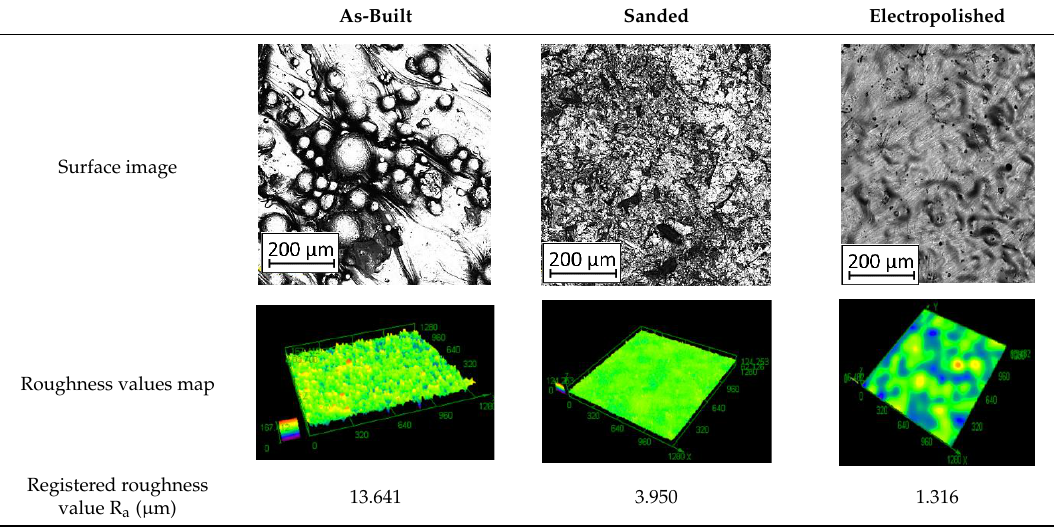
Table 6. The surface roughness of as-built and surface-treated samples.